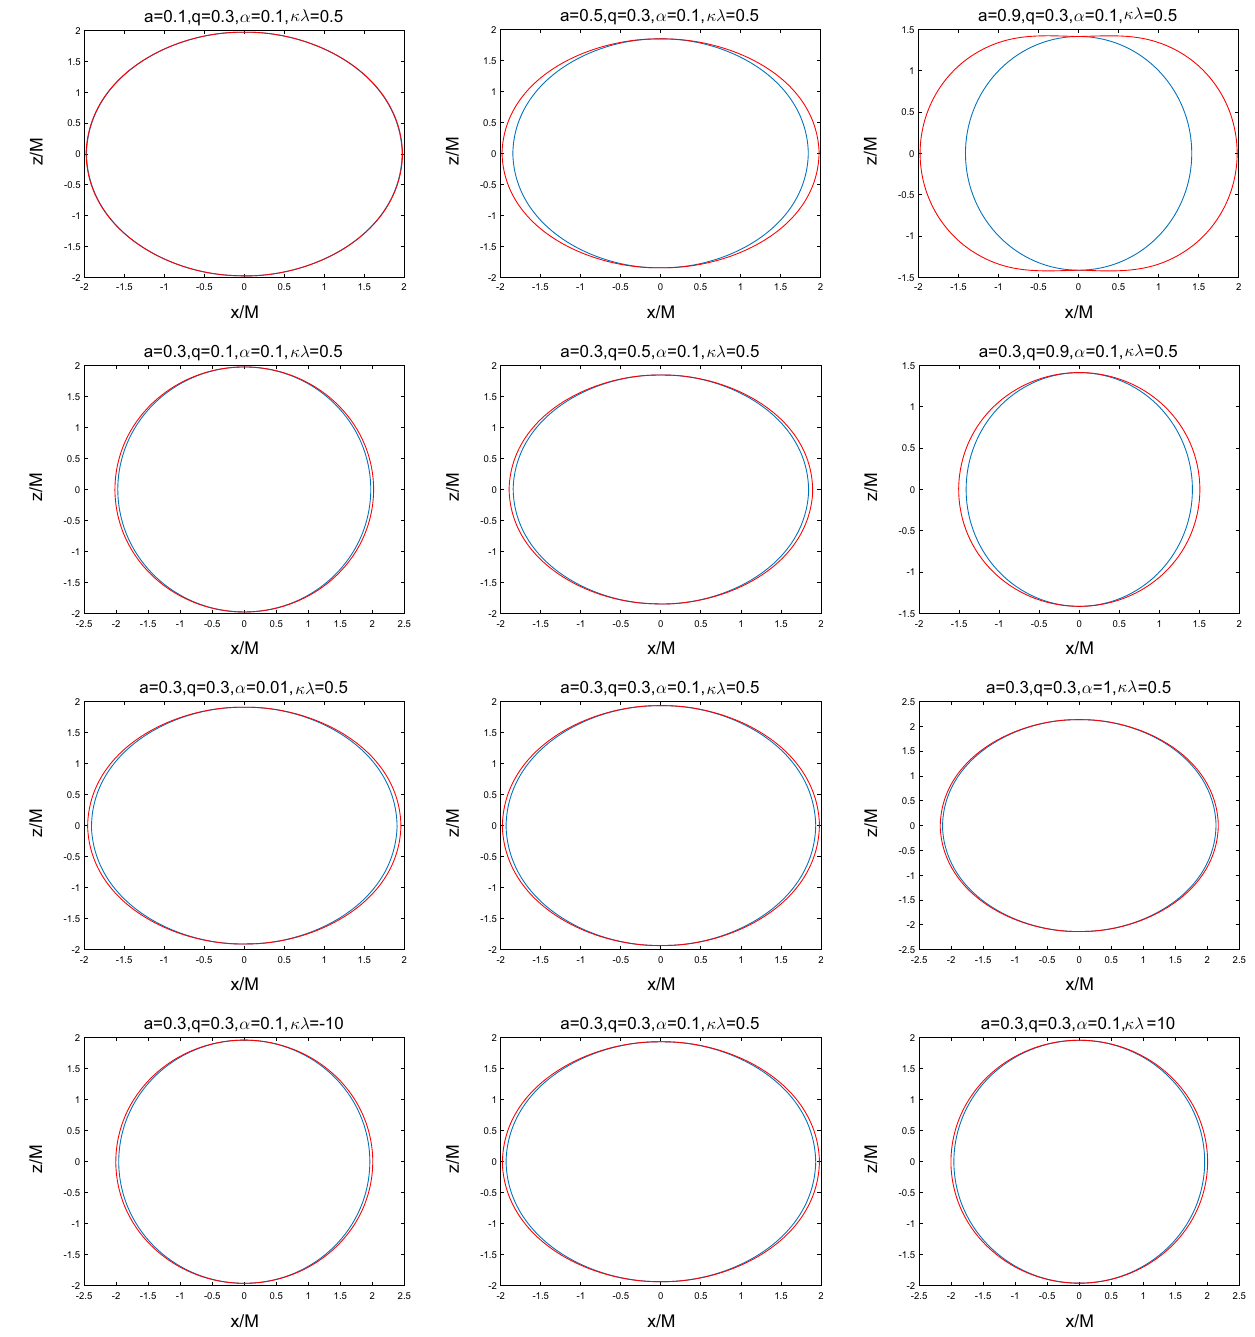
Fig. 2 The ergosphere areas of the KN-AdS black hole surrounded by perfect fluid dark matter ( ω = − 1 / 3) in the Rastall gravity for different a , Q ,α,κλ . The ergosphere region is between the event horizon (blue line) and the stationary limit surface (red line). The cosmological constant is set as (cid:15) (cid:9)